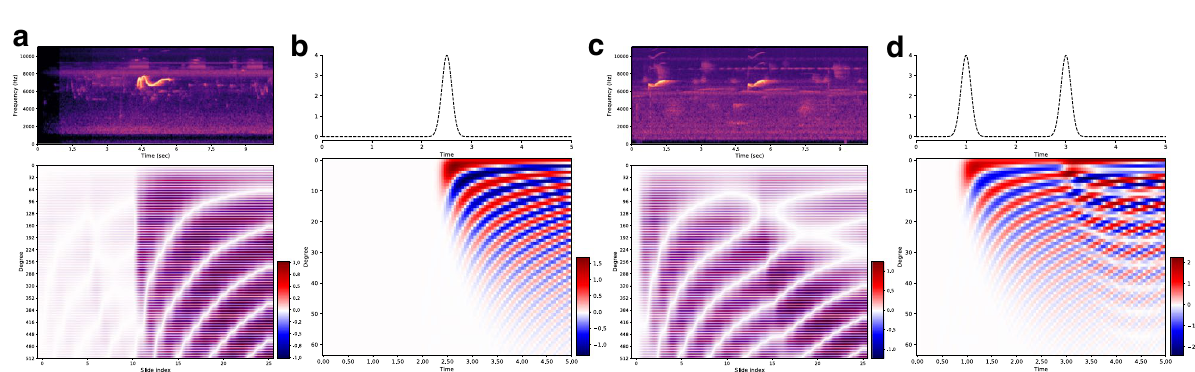
Figure 4. 2D projection of learned representations. We visualize samples from our test set using a 2D projection of the representation using a t-SNE plot for 30 bird species with the most number of examples. The embeddings are shown for CNN3+LMU in the left plot, and for CNN3+GRU in the right with a hidden layer size of 512 for each model.